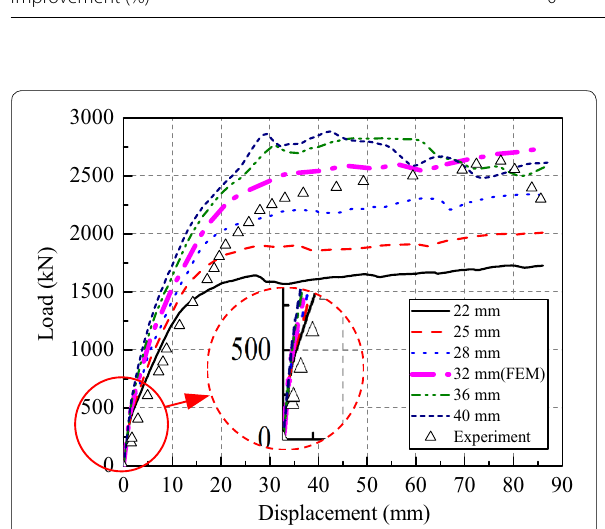
Fig. 27 Effect of the reinforcement ratio of the strut.